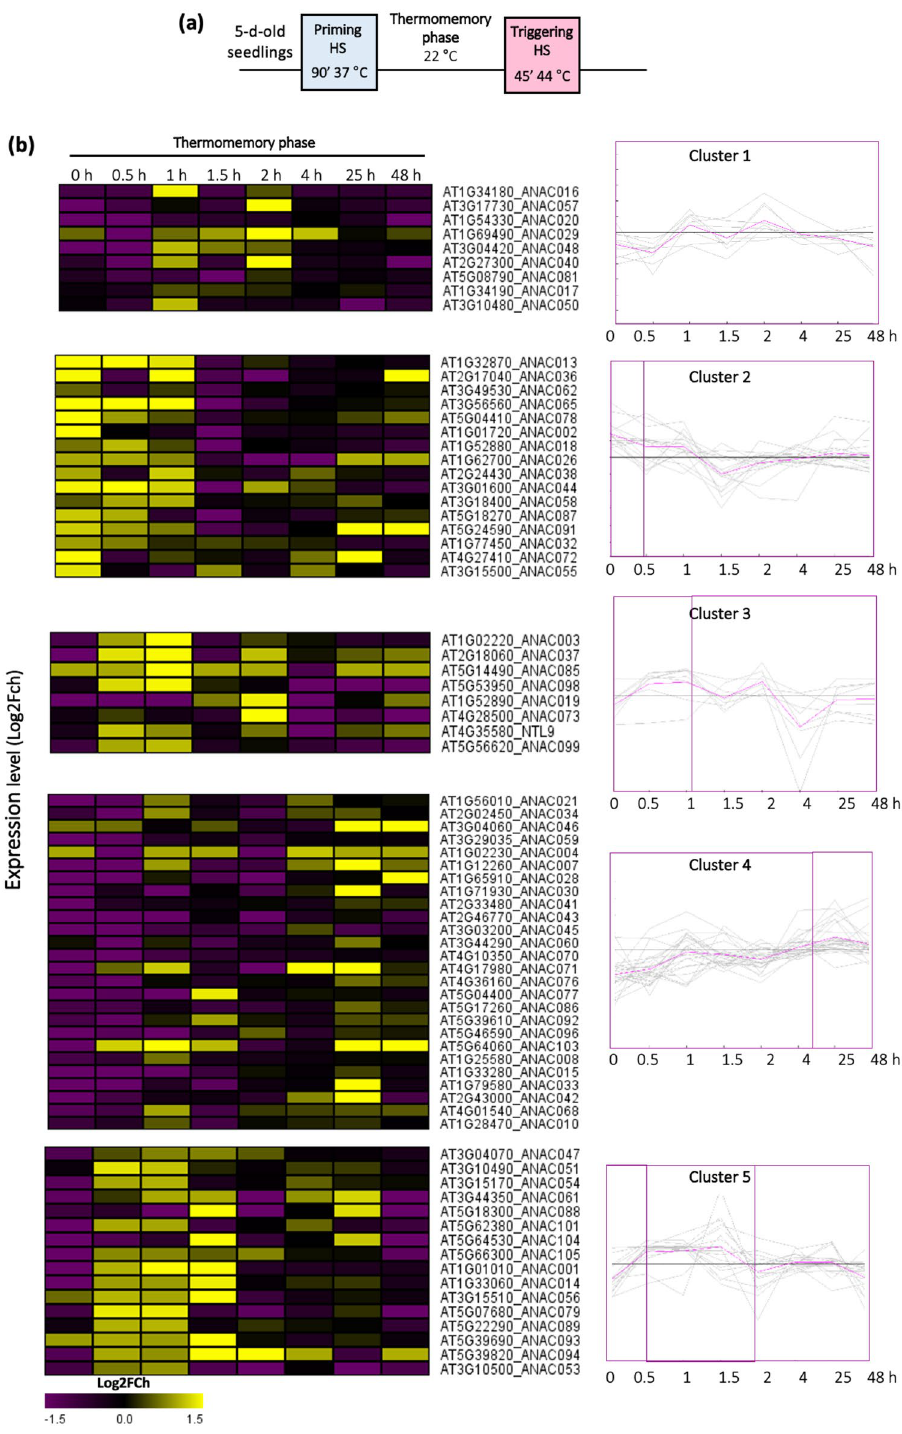
Figure 1. Expression of NAC transcription factors during the memory phase, after heat priming. ( a ) Schematic representation of the heat stress (HS) regime applied to asses HS memory. ( b ) Heat map and k-means clustering (k = 5 clusters) of NACs, based on their change in expression (HS samples compared to unstressed controls) during the memory phase at the time points indicated in the representation in ( a ). The color indicates the expression ratio as log2-fold change for the different time points, where ‘yellow’ denotes an increased expression and ‘purple’ a reduced expression. The list of genes in each cluster and their expression values are shown in Supplementary Table